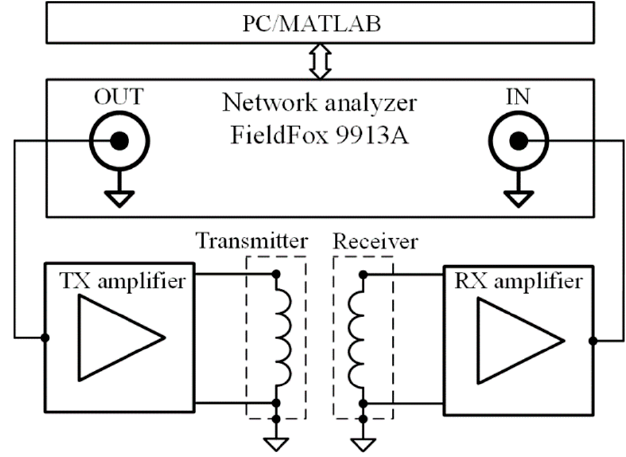
Figure 1. Block diagram of the experimental setup.